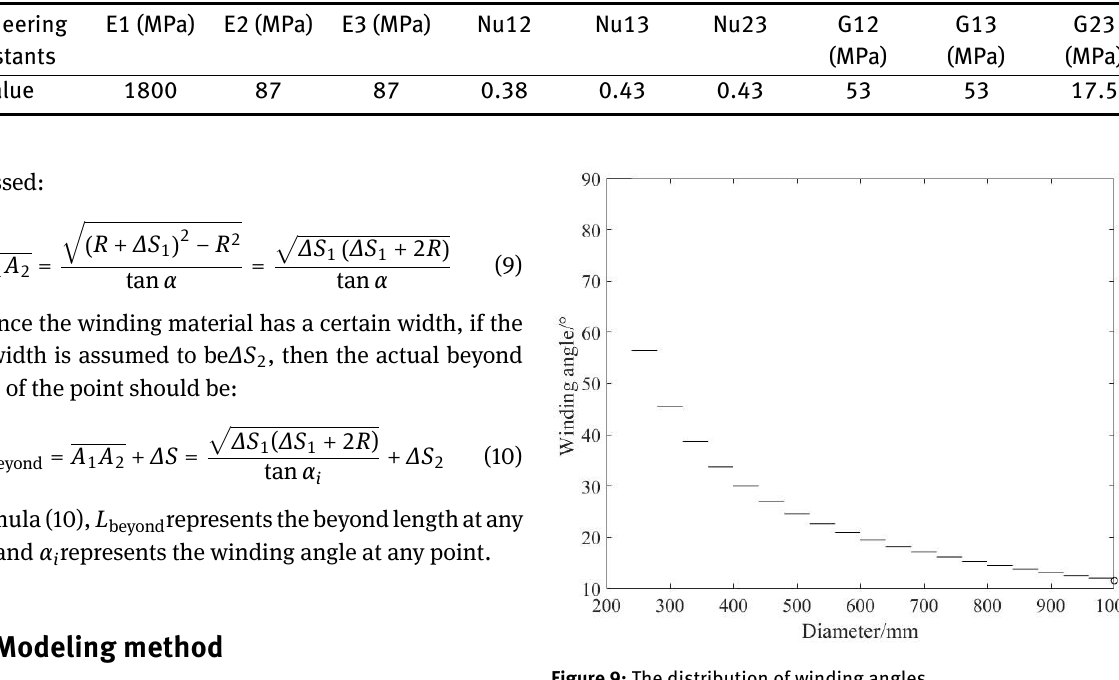
defined as an elastic body and the material property de- fined as an anisotropic composite, the bsaeplate and the upper pressplate are defined as rigid bodies. At the same time, in the finite element simulation design, the thickness of composite layer is set to 10 mm, thickness of each layer is 1 mm, and the winding angles (fiber direction) of each layers are positively and negatively distributed. The ma- terial and parameters (as shown in Table 3) of composite winding layer are tested and provided by Hengshui Rub- ber Technology Co., Ltd. The conical composite layers are evenly divided into 20 assemblies along the axis of the